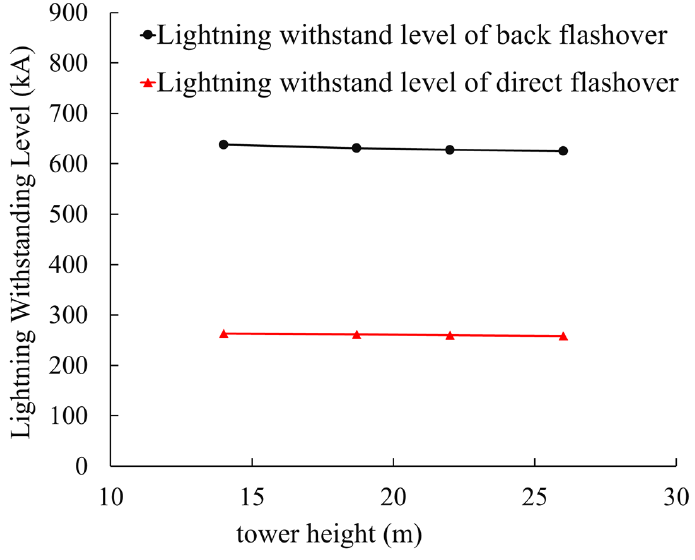
Figure 7. Influence of tower height on